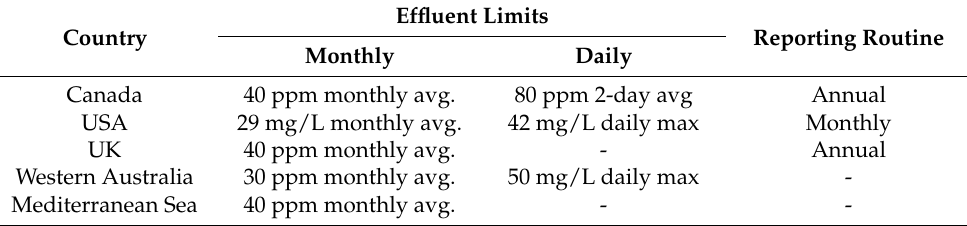
Table 3. Produced water effluents discharge limit for different countries